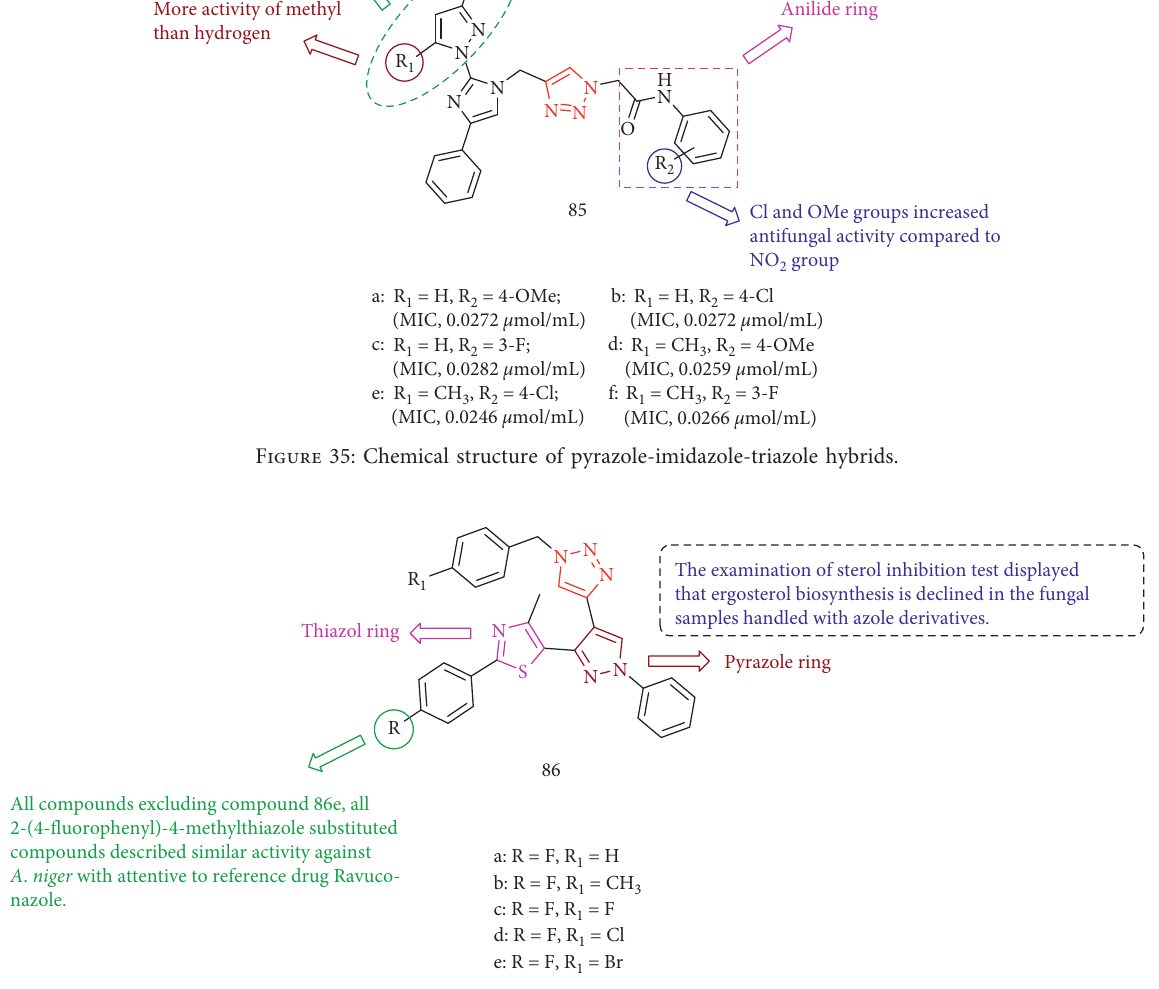
Figure 36: Chemical structure of new thiazolyl-pyrazolyl-1,2,3-triazole derivatives.